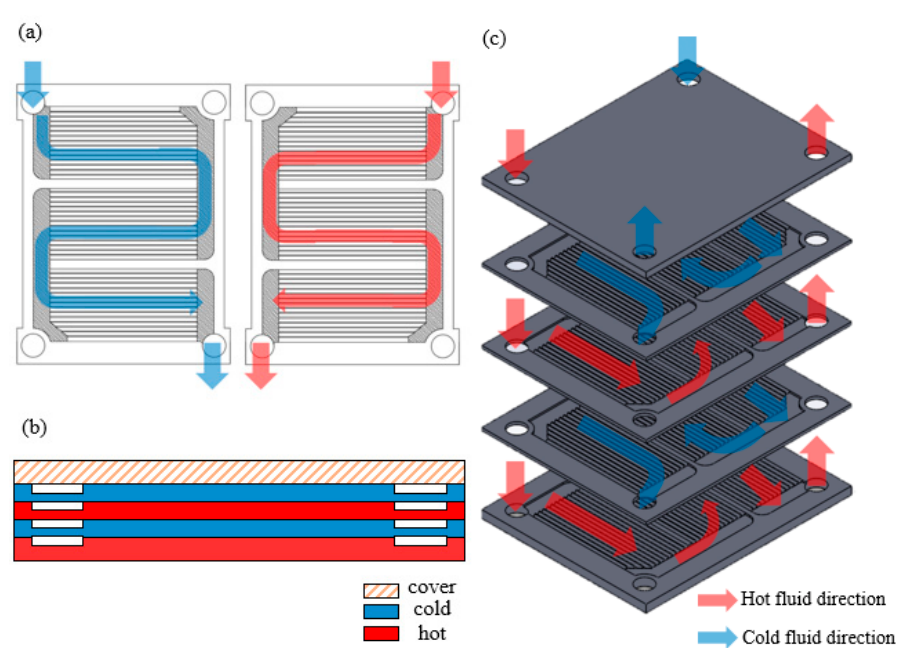
Figure 1. ( a ) The design of the PCHE; ( b ) hot fluid flow plate and cold fluid flow plate in the PCHE.